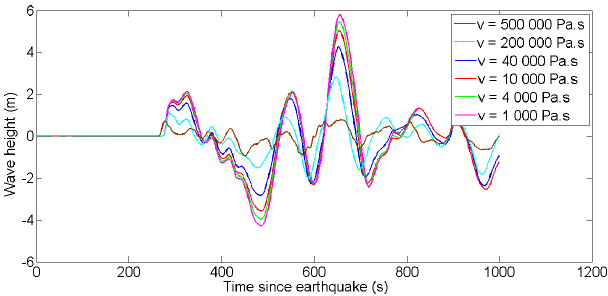
Figure 9. Time series calculated at synthetic gauge G 2 located on the coast of the Bay of Jacmel (green circle in Fig. 8). This calcula- tion uses a bathymetric grid with 25m resolution.